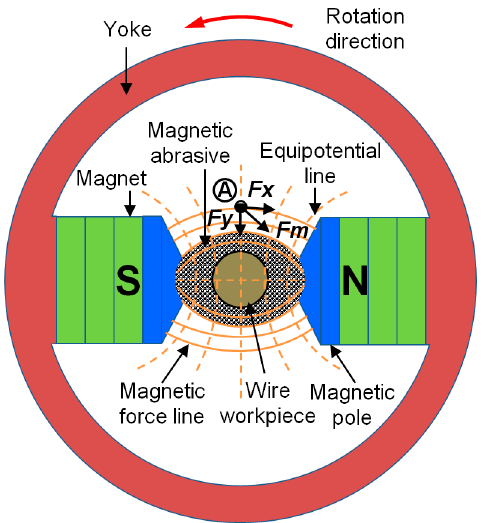
Figure 1. Schematic of processing principle for an ultra-high-precision magnetic abrasive finishing.